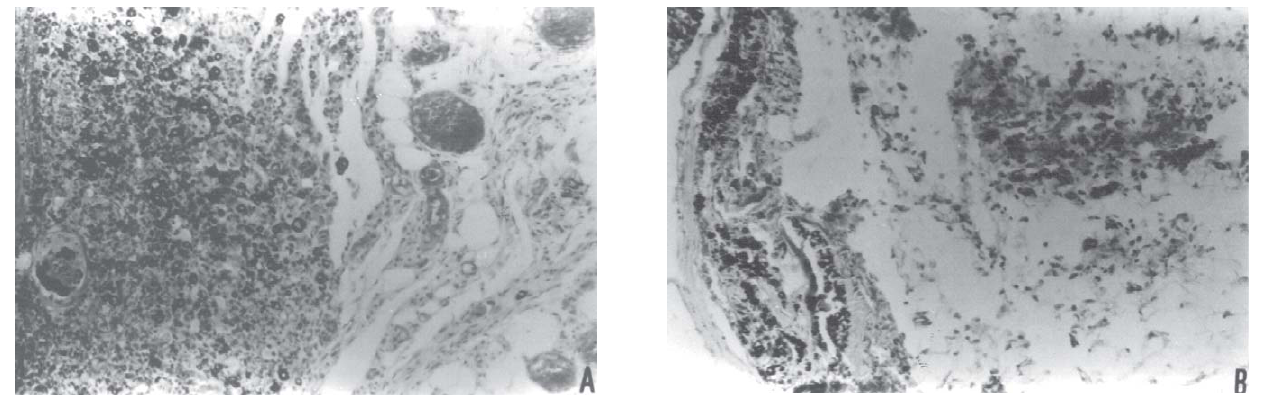
FIGURE 4- Response of the connective tissue in contact with Ketac Endo cement (arrows): 14-day experimental period (A) and 90-day experimental period (B).